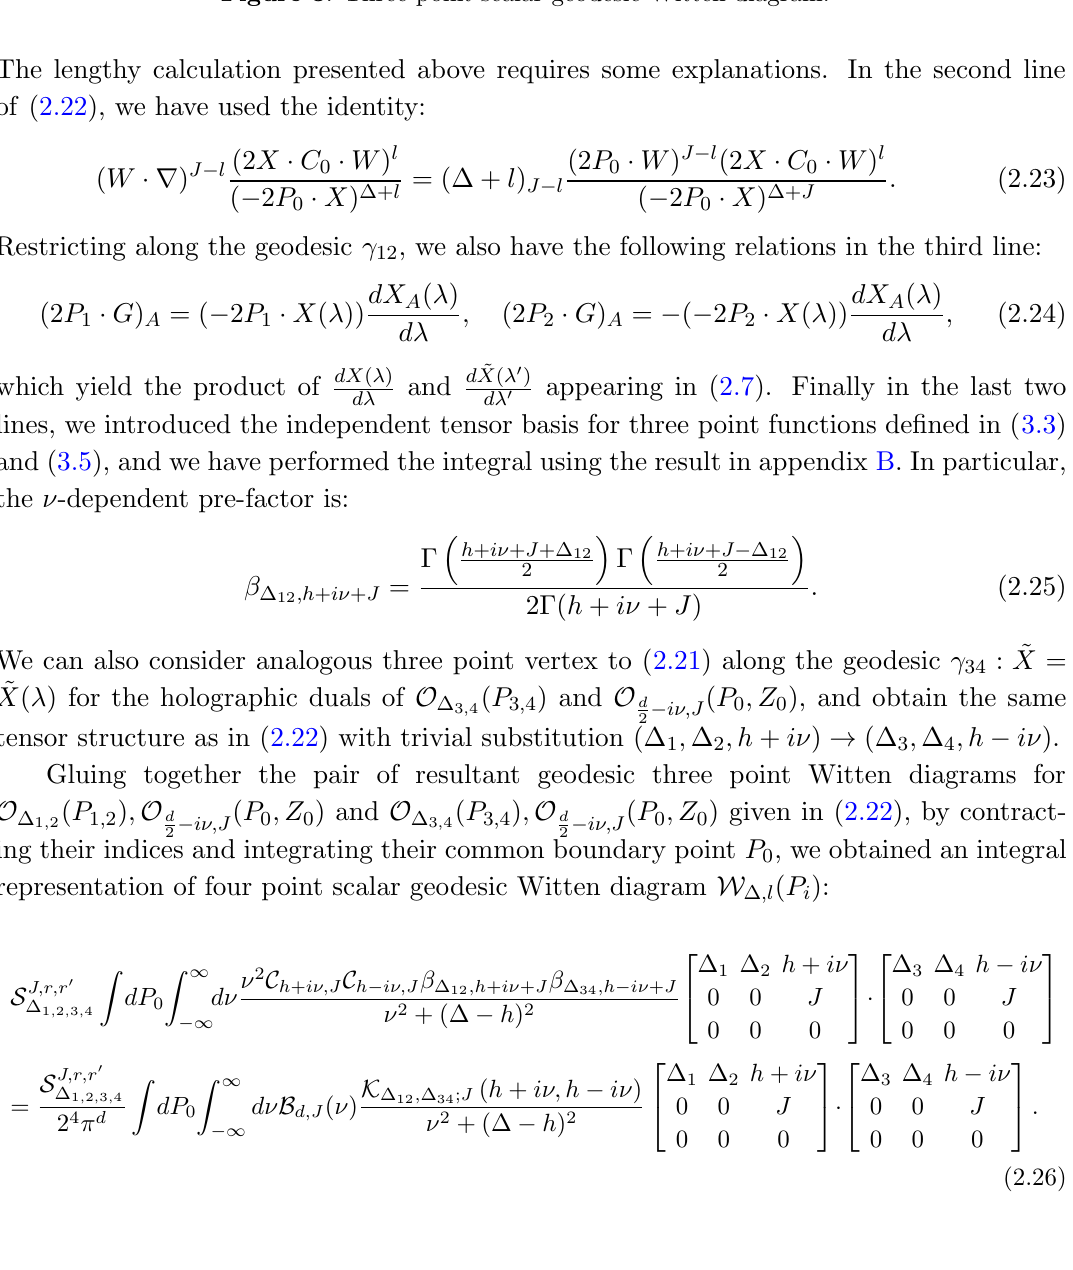
Figure 3 . Three point scalar geodesic Witten